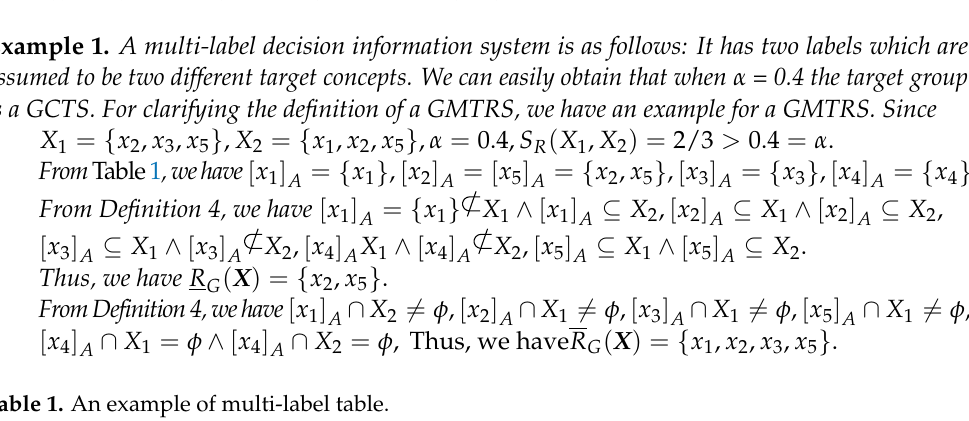
Table 1. An example of multi-label table. U